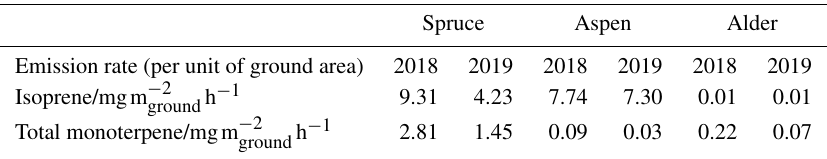
Table 3. Input parameters for estimating annual BVOC emissions for different SRF species plots at East Grange, Fife, Scotland, using the MEGAN 2.1